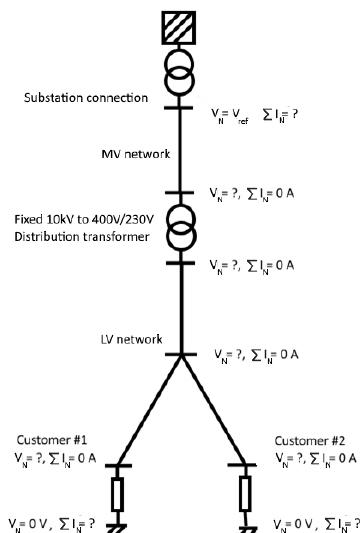
Figure 1. An example of a small medium voltage/low voltage (MV/LV) network connected to a substation transformer. While the MV network is always operated radially, the LV network is operated meshed in some areas. The reference voltage ( V ref ) is defined at the secondary side of the substation transformer. If only the LV network is considered, the reference voltage ( V ref ) is defined at the secondary side of the distribution